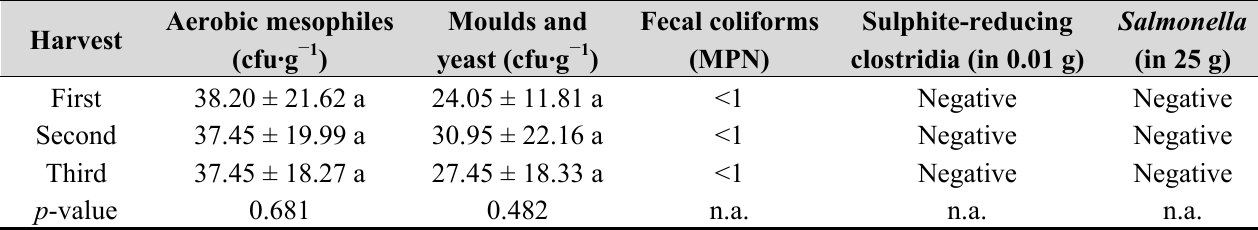
Table 2. Microbial analyses of “Terra Quente” honey